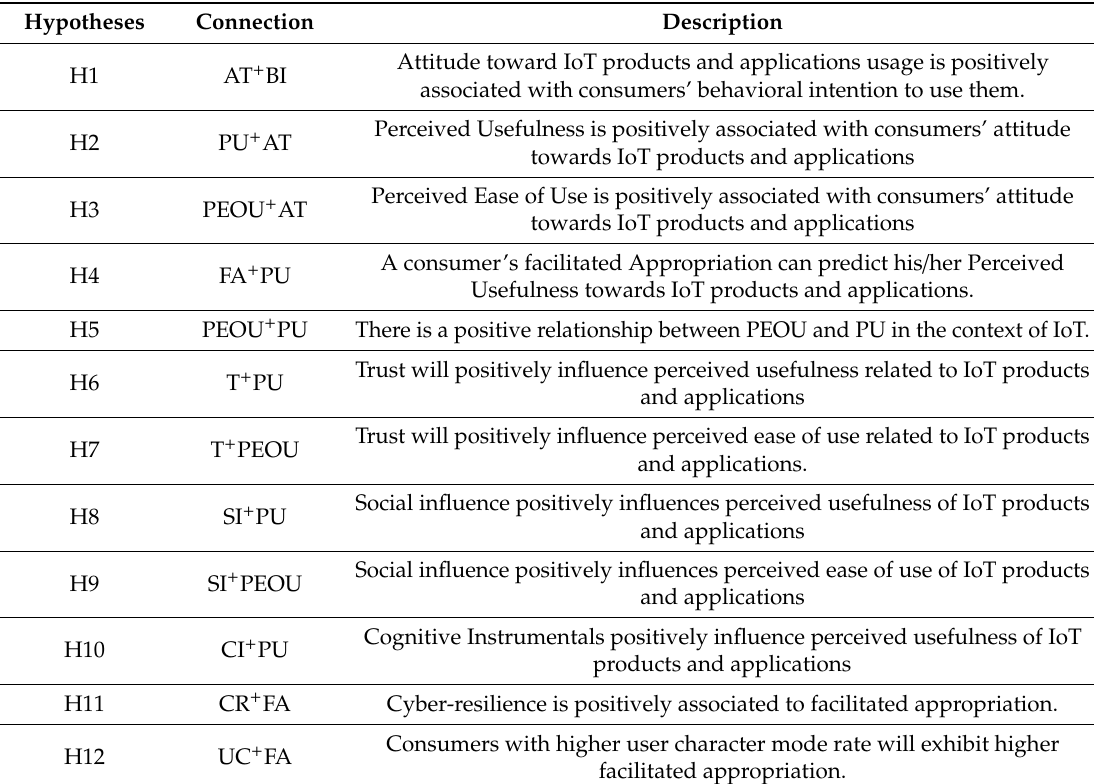
Table 1. Research